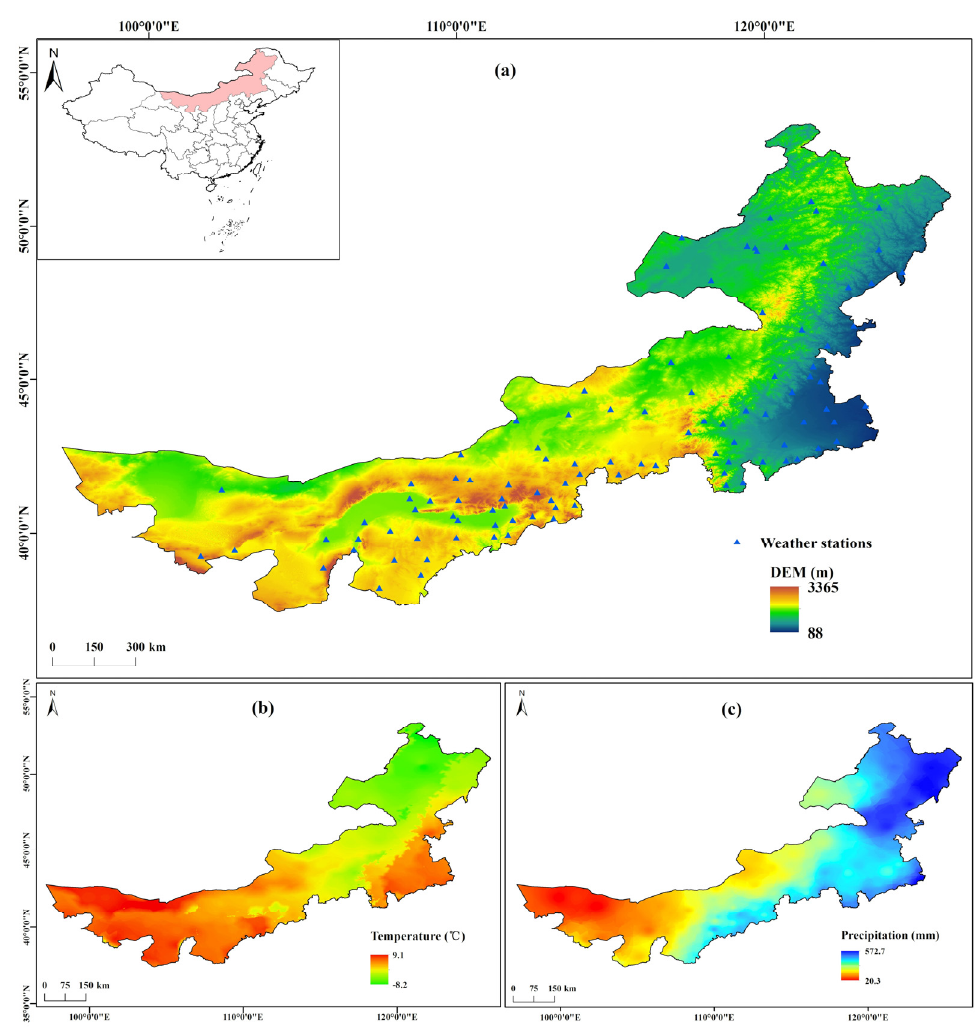
Figure 1. Geographical location and climatic characteristics of Inner Mongolia. ( a ) Meteorological station distribution and Digital Elevation Model (DEM), ( b ) annual average temperature, and ( c ) annual average precipitation.